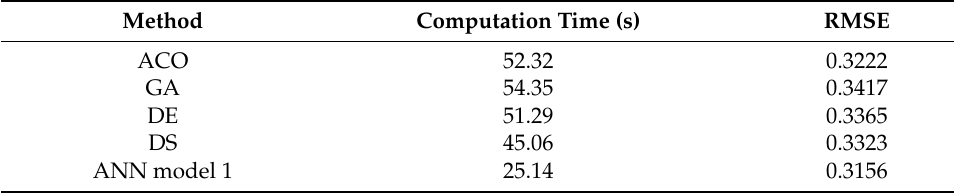
Table 7. Comparison with some optimization